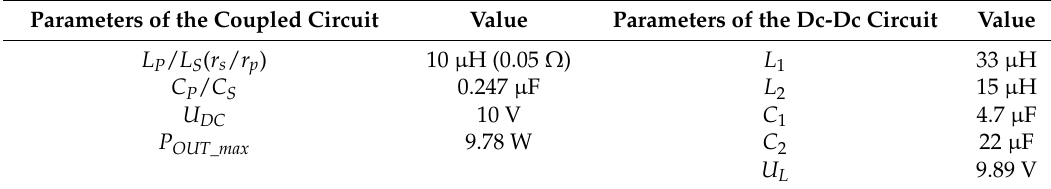
Table 1. Key Simulation Parameters of Proposed IPT